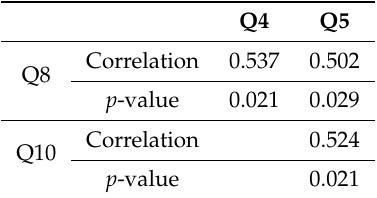
Table 4. Significant correlations between course materials and course understanding.